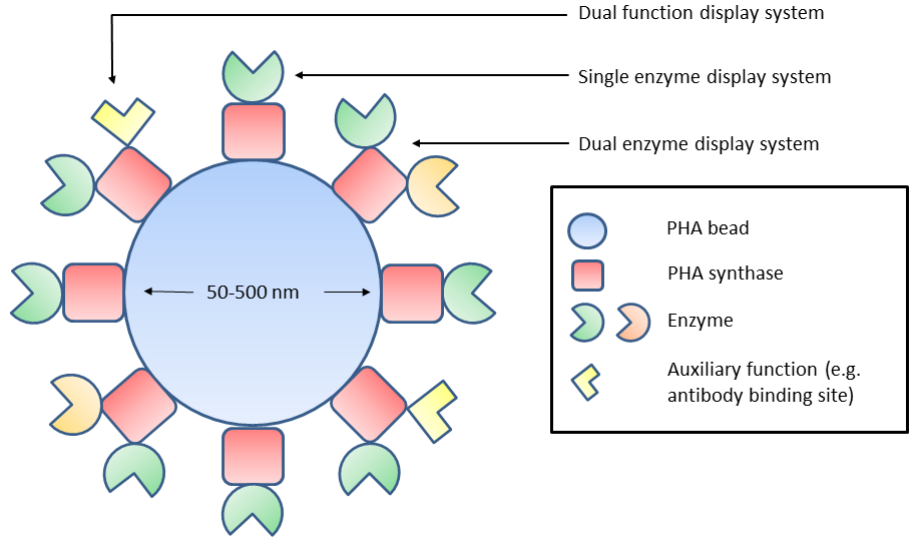
Figure 2. Potential applications of the PHA bead display